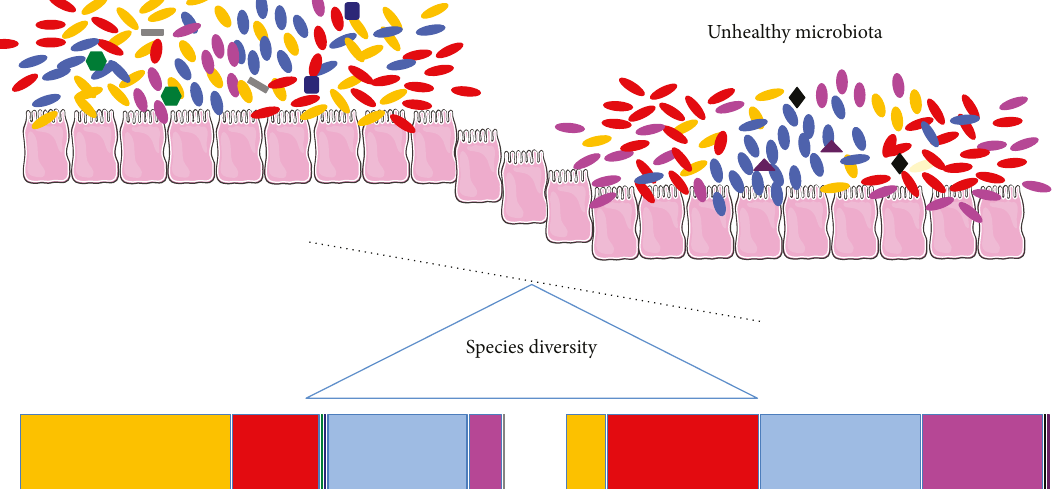
Figure 1: Healthy microbiota is a balanced community of symbiont, commensal, and pathobiont microorganisms. Each microbial class confers distinct characteristics to the host. Either imbalance in alpha-diversity or variations of relative abundance of single microbial taxa results in microbiota imbalance. As such, a sterile in fl ammation occurs and may predispose the host to opportunistic infections, ultimately leading to acute in fl